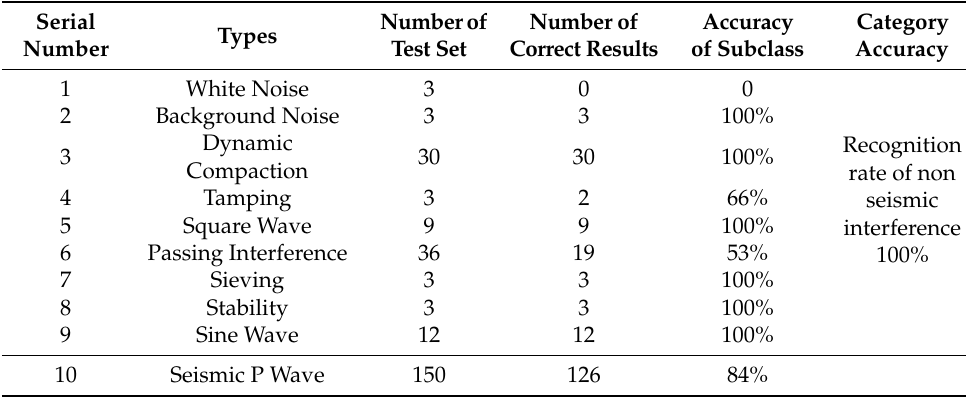
Table 2. Experimental Results of Classification